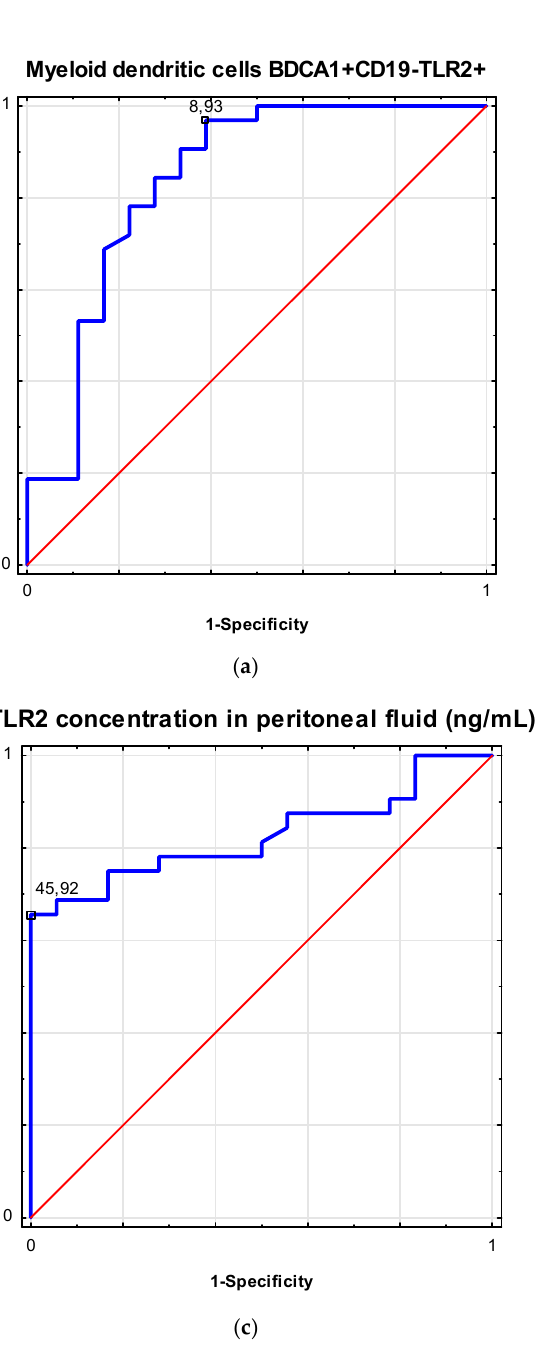
Figure 3. Receiver operating curve (ROC) analysis to determine diagnostic accuracy in differentiation of patients with ovarian cancer in III/IV FIGO stages and FIGO stages I/II: ( a ) frequencies of myeloid dendritic cells BDCA1+ CD19 − TLR2+ (%); ( b ) frequencies of plasmacytoid dendritic cells BDCA2+ CD123+ TLR2+ (%); ( c ) TLR2 concentration in peritoneal fluid (ng/mL); ( d ) frequencies of T lymphocytes CD8+ TLR2+ (%) as a destimulant.